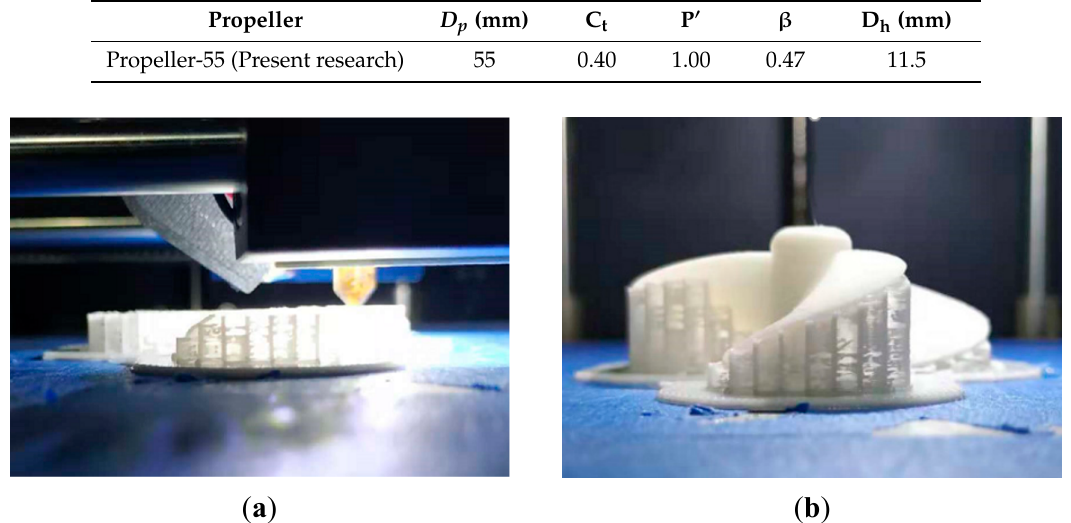
Figure 4. Three-dimensional (3D) printing for propeller model. ( a ) Printing in progress; and, ( b ) Printing completion.